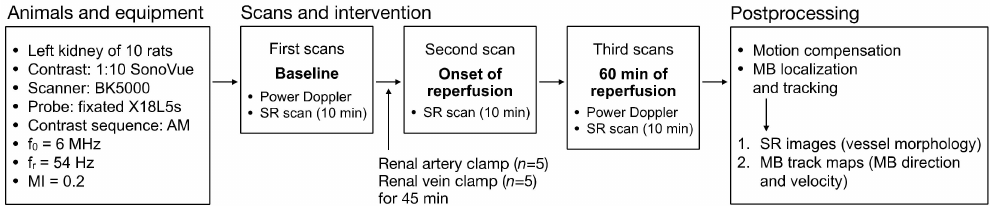
Figure 1. Experiment overview of the ischemia-reperfusion intervention. AM = amplitude modulation, f 0 = center frequency of the probe, f r = frame rate, MI = mechanical index, SR = super-resolution, MB =